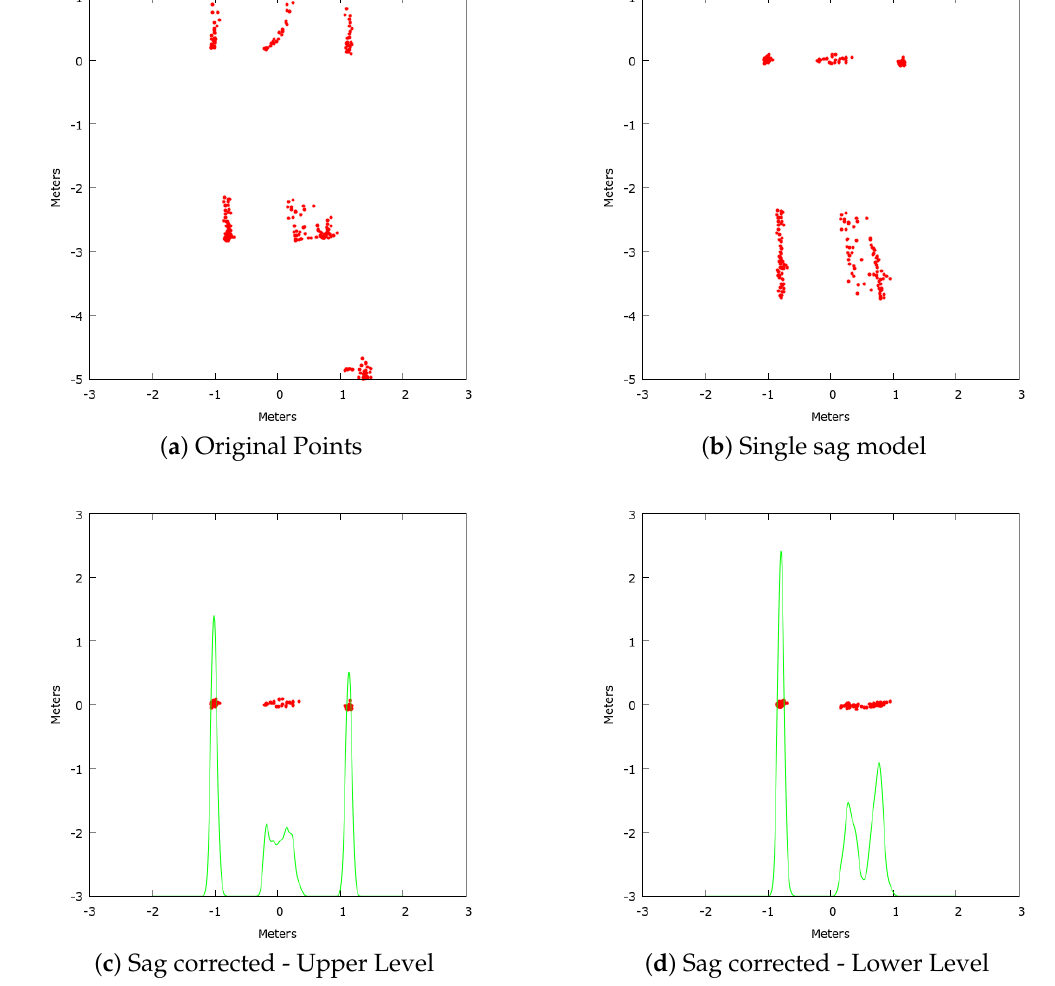
Figure 7. These figures show the projection of points onto the clustering plane for the span featured in Figures 4 and 5. ( a ) shows the points projected without sag removal, the points in the lower right belong to a nearby tree. ( b ) shows the projected points using a single sag model. Note the spread of the points on the lower level has increased when compared with the original points. ( c , d ) show the upper and lower levels after sag removal using separate sag estimation models. The probability density function is plotted to better show the point